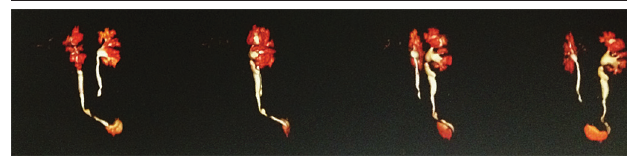
figurE 4 − Dynamic renal scintigraphy showing upper urinary tract obstruction to the